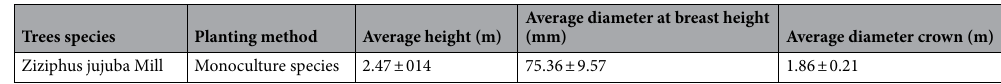
Table 1. The biological characteristics of Jujube orchard